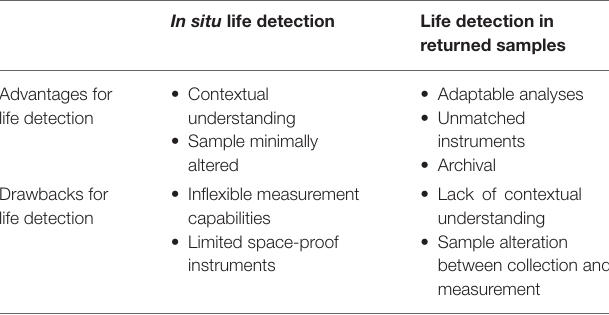
TABLE 1 | Relative merits of in situ and sample return missions for life